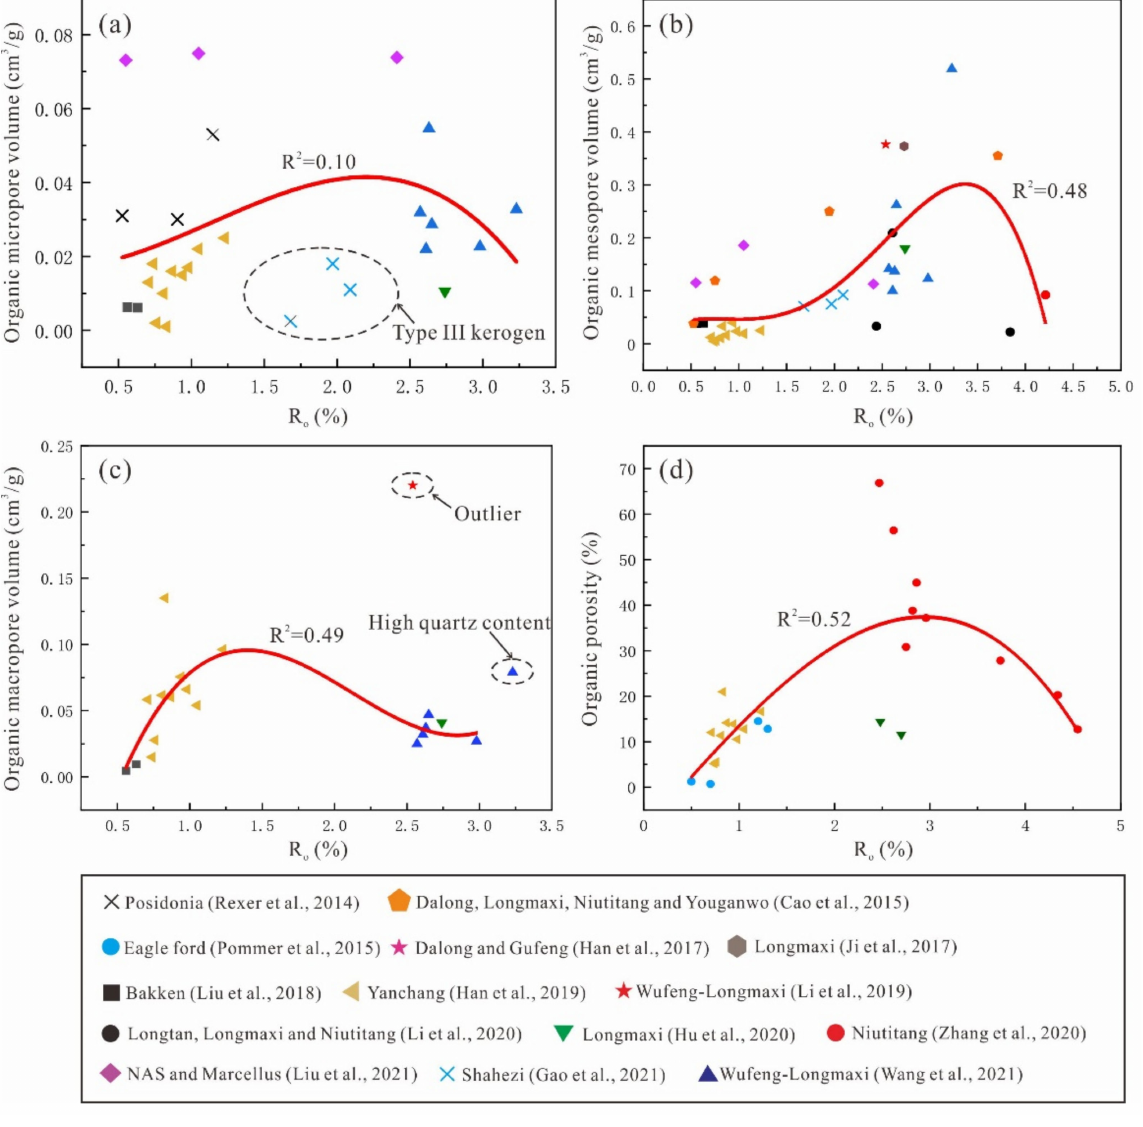
Figure 4. Pore structure and porosity evolution of organic pores with increasing thermal maturity in shale. ( a ) Micropore volume. ( b ) Mesopore volume. ( c ) Macropore volume. ( d ) Organic porosity of shale samples. Data are from